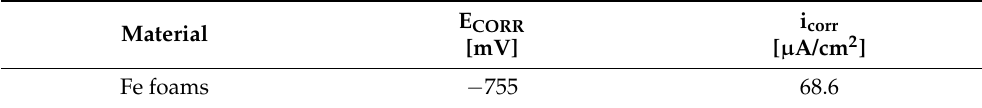
Figure 5. Potentiodynamic polarization curves ( a ) and the mass loss during immersion for 5 weeks ( b ) of the manufactured foams in PBS solution, pH 7.4 at 37 ± 1 °C. Table 3. The avarage values for the corrosion potentials (Ecorr) and corrosion current resistance (i corr ) obtained from the potentiodynamic polarization curves in PBS solution at 37.1 °C.